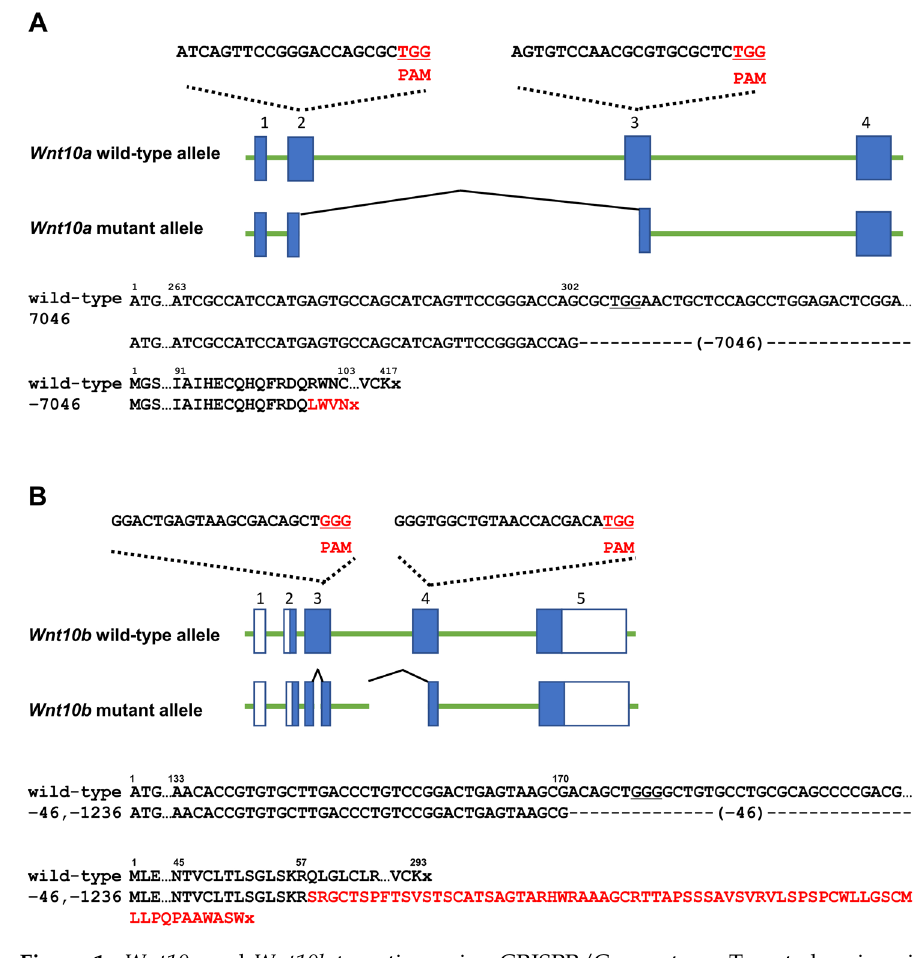
Figure 1. Wnt10a and Wnt10b targeting using CRISPR/Cas system. Targeted regions in mouse Wnt10a ( A ) and Wnt10b ( B ) for genome editing. The PAM sequence is highlighted in red. The pre- dicted consequences of the mutation on amino acid sequences are highlighted in red. The stop co- dons are shown as x.